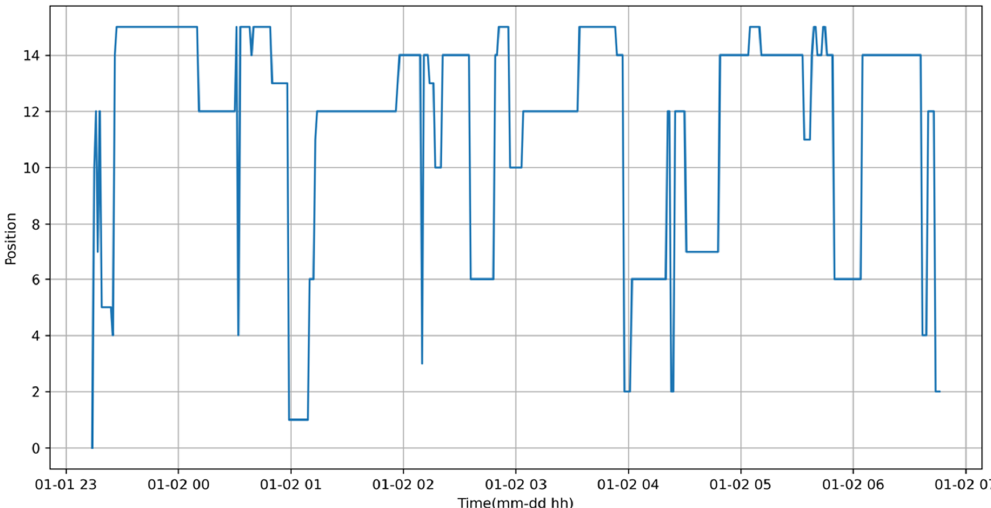
Figure 17. The distribution of the head position for user2.